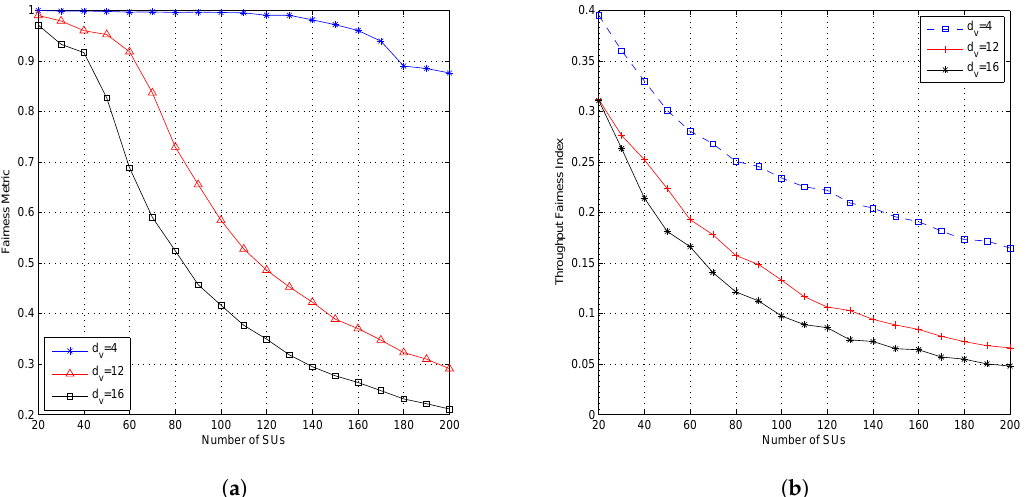
Figure 11. Performance of the proposed algorithm with the variation value of d v and fixed d c ( d c = 9); ( a ) fairness metric and ( b ) throughput fairness